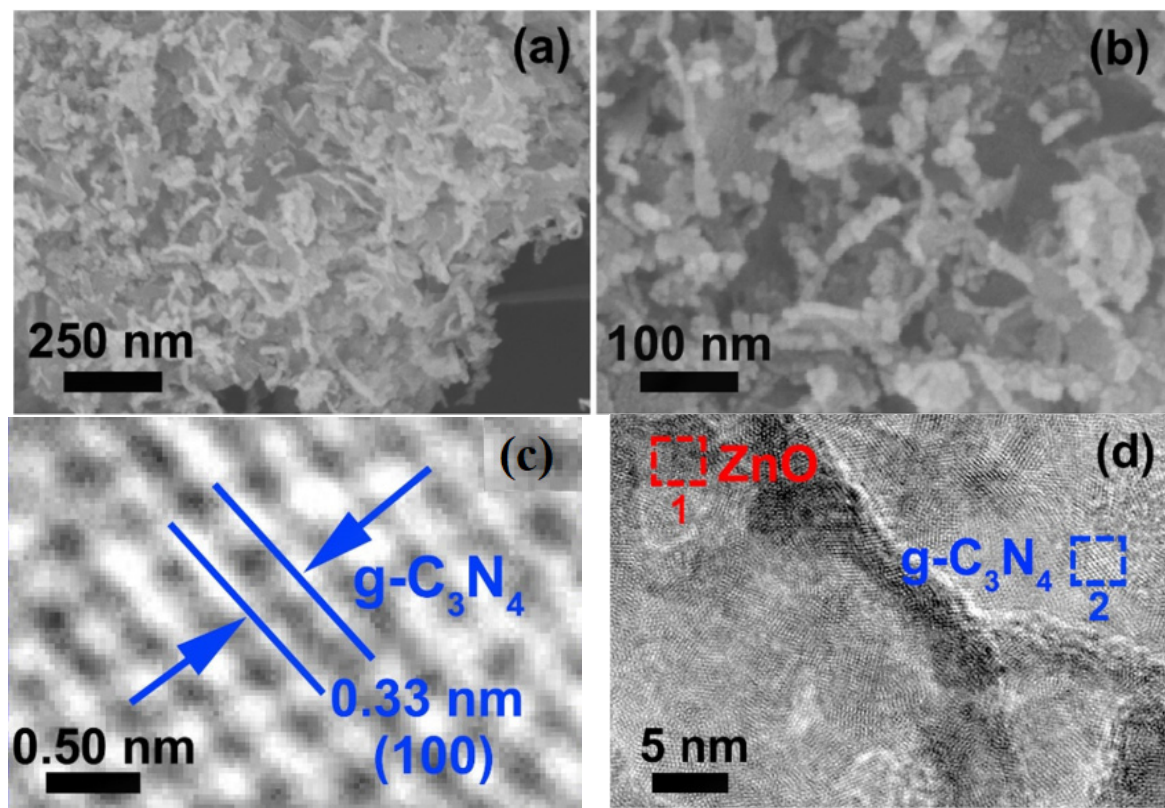
Figure 10. SEM ( a , b ) and HRTEM images ( c , d ) of g-C 3 N 4 -ZnO@GA (30%) [93].